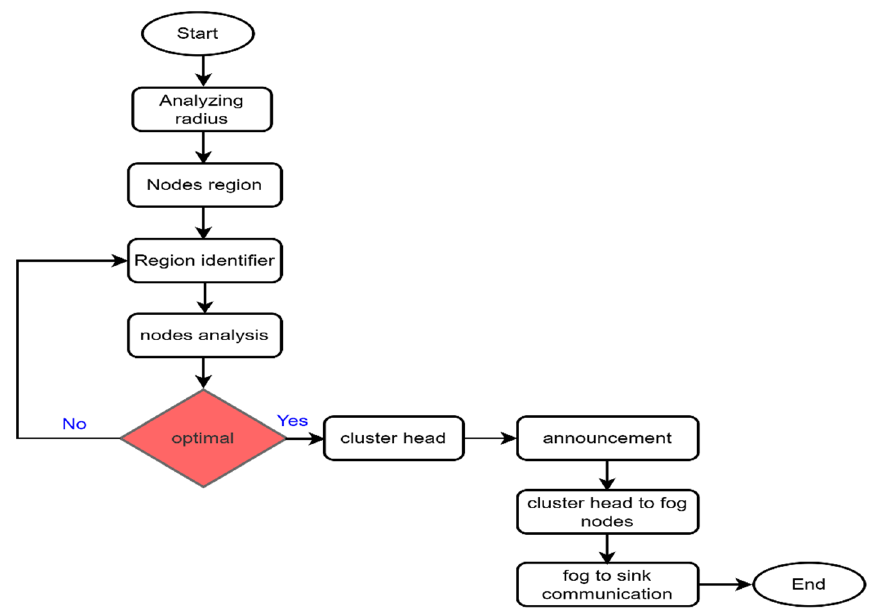
Figure 2. Flowchart of the proposed algorithm. Algorithm 1 elaborates the pseudocode of the proposed algorithm in terms of data routing using efficient chaining and resource